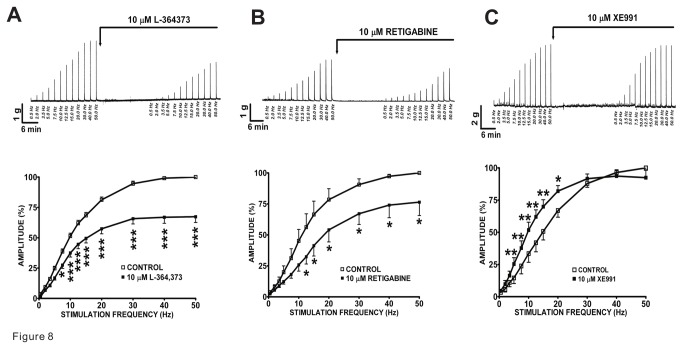
Effect of Kv7 channel modulators on the 0.5–50 Hz EFS-induced contractions in guinea pig DSM isolated strips.
A-B) The original DSM tension recordings and frequency-response curves illustrate the inhibitory effects of L-364373 (n=7, N=4) and retigabine (n=6, N=4) on the 0.5–50 Hz EFS-induced contraction amplitude. C) The original DSM tension recording and frequency-response curves reveal that XE991 enhanced the 0.5-20 Hz EFS-induced contraction amplitude (n=8, N=5). The maximal EFS-induced contraction amplitude at a stimulation frequency of 50 Hz under control conditions was taken to be 100%; *P<0.05, **P<0.01, ***P<0.005 versus control.